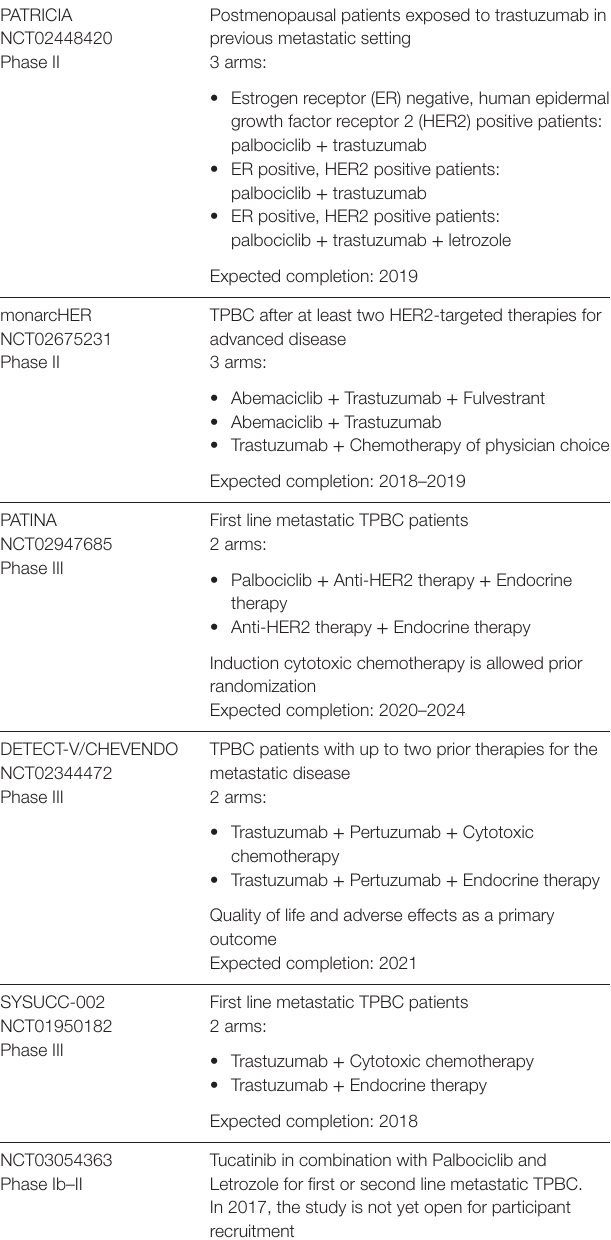
TABLe 2 | Ongoing clinical trials in metastatic triple positive breast cancer